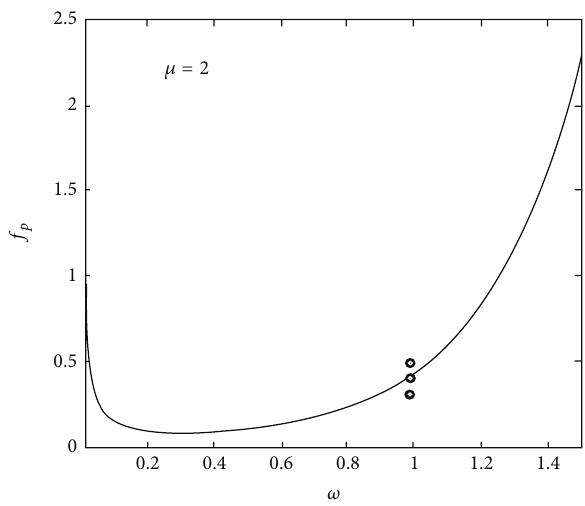
Figure 3: Phase portrait and homoclinic orbits of unperturbed sys- tem.